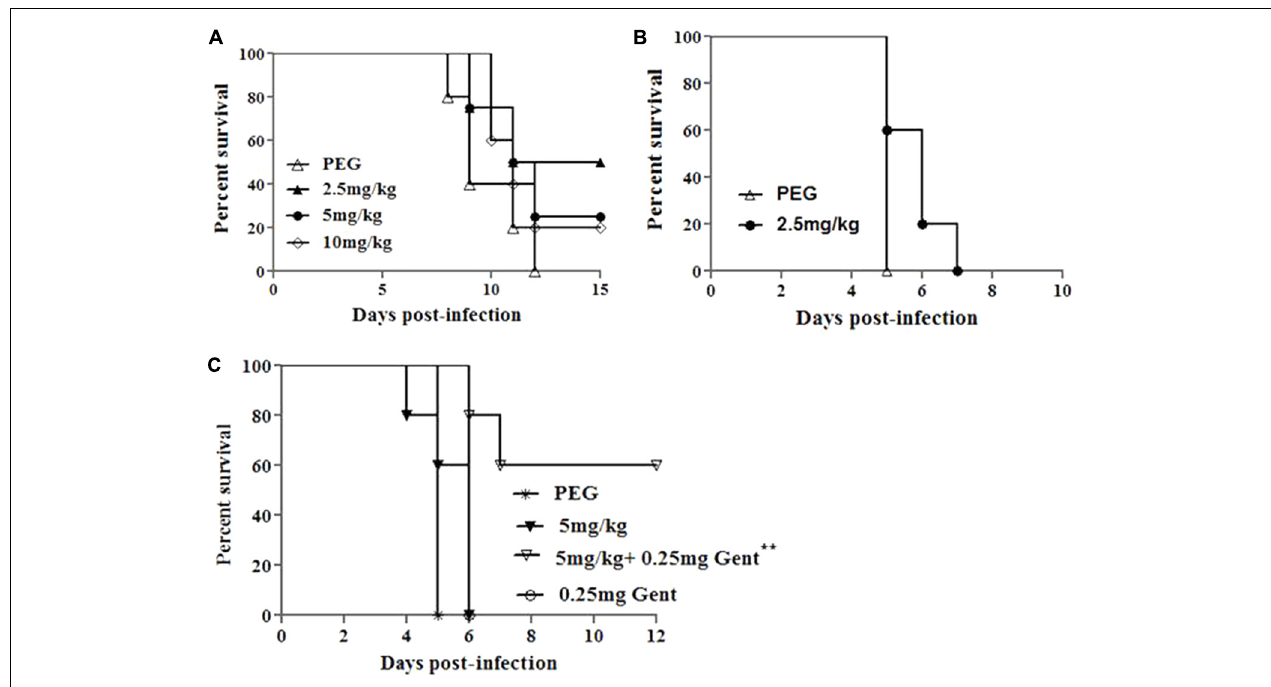
FIGURE 6 | Protective effects of AR-13 in a mouse model of tularemia. (A) Survival curves of BALB/c mice infected by the I.N. route with 3 × 10 3 CFU of LVS followed by AR-13 treatment. The infected mice (4 or 5 mice/group) were given 2.5, 5, or 10 mg of AR-13/kg/day, starting about 1 h post-infection, once daily from day 0 for 10 days. A control PEG group was included. (B) Survival curves of BALB/c mice (5 mice/group) infected by the I.N. route with 10 CFU of F. tularensis SchuS4 followed by AR-13 treatment. Infected mice were given 2.5 mg AR-13/kg/day starting about 1 h post-infection, once daily from day 0 until day 4. (C) Survival curves of BALB/c mice (5 mice/group) infected I.N. with 10 CFU of F. tularensis SchuS4 followed by AR-13 treatment. The infected mice were given 5 mg AR-13/kg/day, starting about 1 h post-infection, with or without 0.25 mg gentamicin/kg/day given I.P.. AR-13 was given once daily from day 0 until day 4; gentamicin was given once daily from day 0 until the end of the experiment. A control PEG group was included ( ∗∗ difference with respect to PEG and 0.25 mg gentamicin control groups, p <